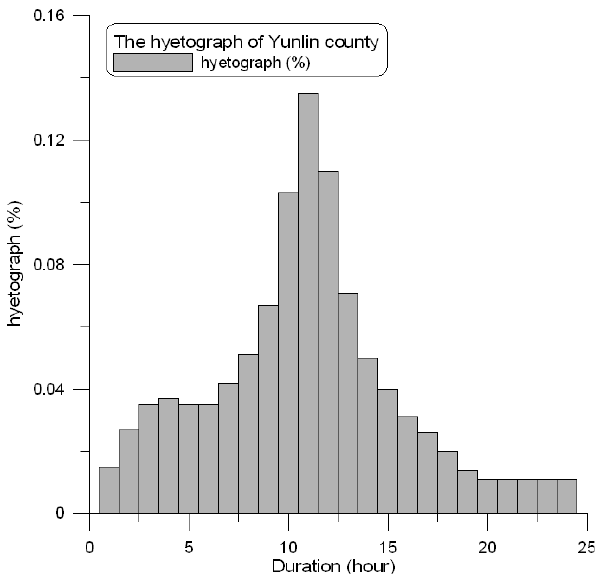
Table 1. Frequency analysis of 24-h cumulative rainfall of